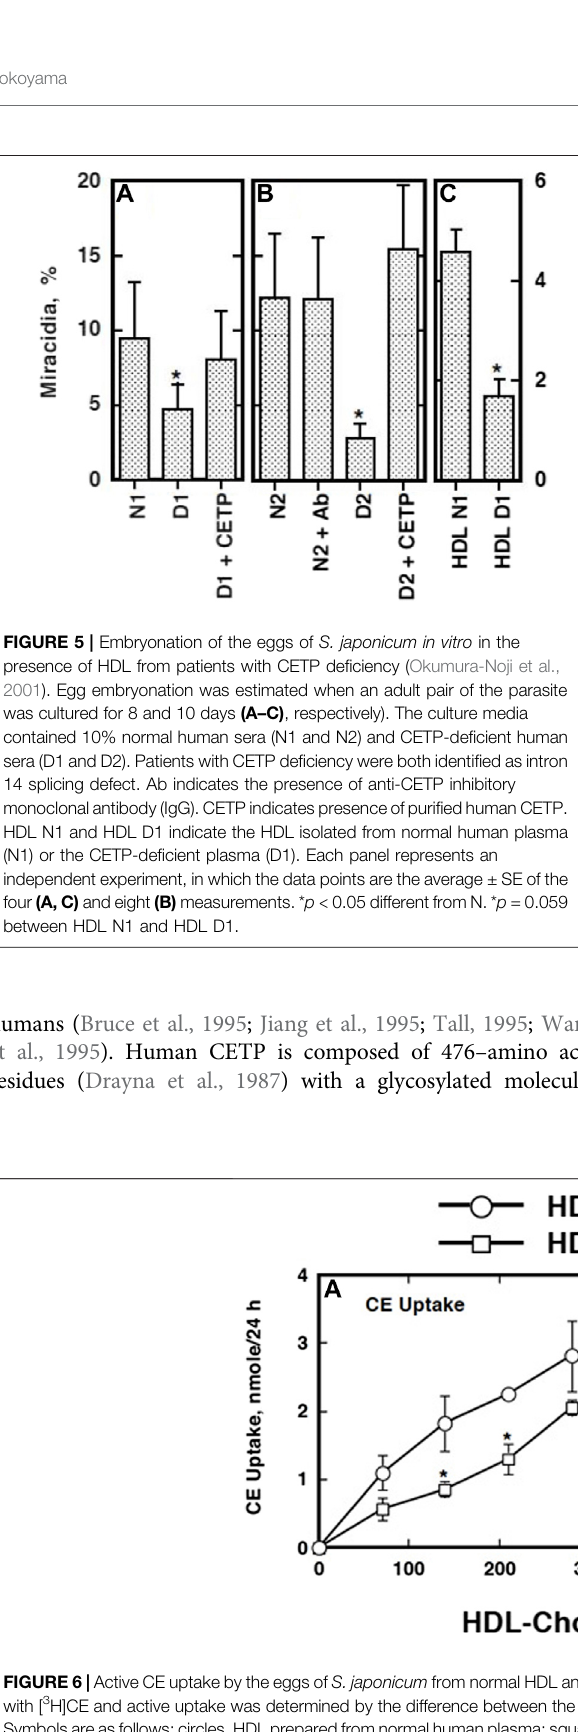
Frontiers in Cell and Developmental Biology |